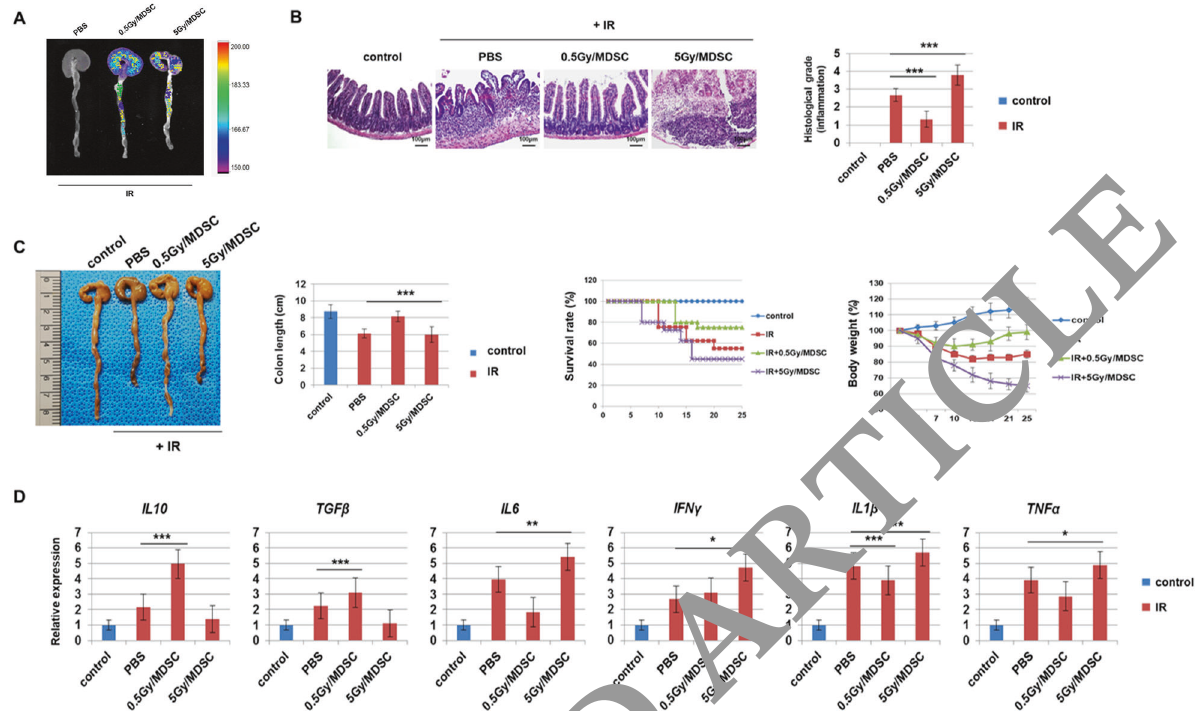
Fig. 4 Adoptive transfer of MDSCs ameliorated radiation-induced intestinal injury and in fl ammation. Adoptive transfers of 0.5 Gy- or 5 Gy- induced splenic MDSCs were intravenously injected in mice on days 1 and 4 after irradiation. A Mice were injected with CFSE-labeled 0.5 Gy- or 5 Gy-induced splenic MDSCs (5 × 10 6 cells/100 µL) twice after irradiation. Fluorescence images of intestines were obtained 24 h after injections using an IVIS 200 image system. B Photomicrographs of colon sections and histological grades of mice 21 days after irradiation. Scale bar = 100 μ m. C Photomicrograph of colons and measurements of colon length, survival rates, and body weights in mice 21 days after irradiation. D The relative expression of cytokines (IL10, TGF β , IL6, IFN γ , IL1 β , and TNF α ) in the intestines of irradiated mice were measured using qRT-PCR. The data are represented as the mean ± SD ( n = 8). * P < 0.05, ** P < 0.01, *** P < 0.001 vs. PBS. IR